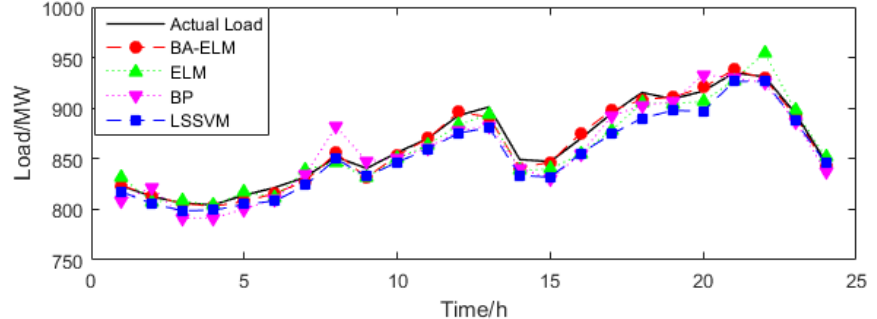
Figure 9. Compared load forecasting results on 29 June.